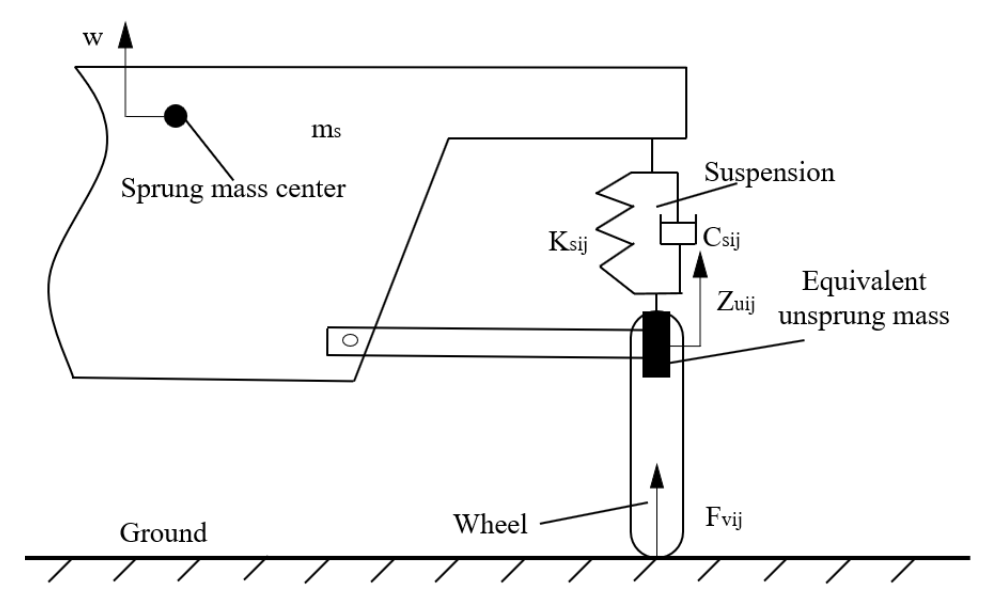
Figure 4. Suspension model. The unsprung mass of the suspension components and wheels is replaced by the equivalent unsprung mass in this model.